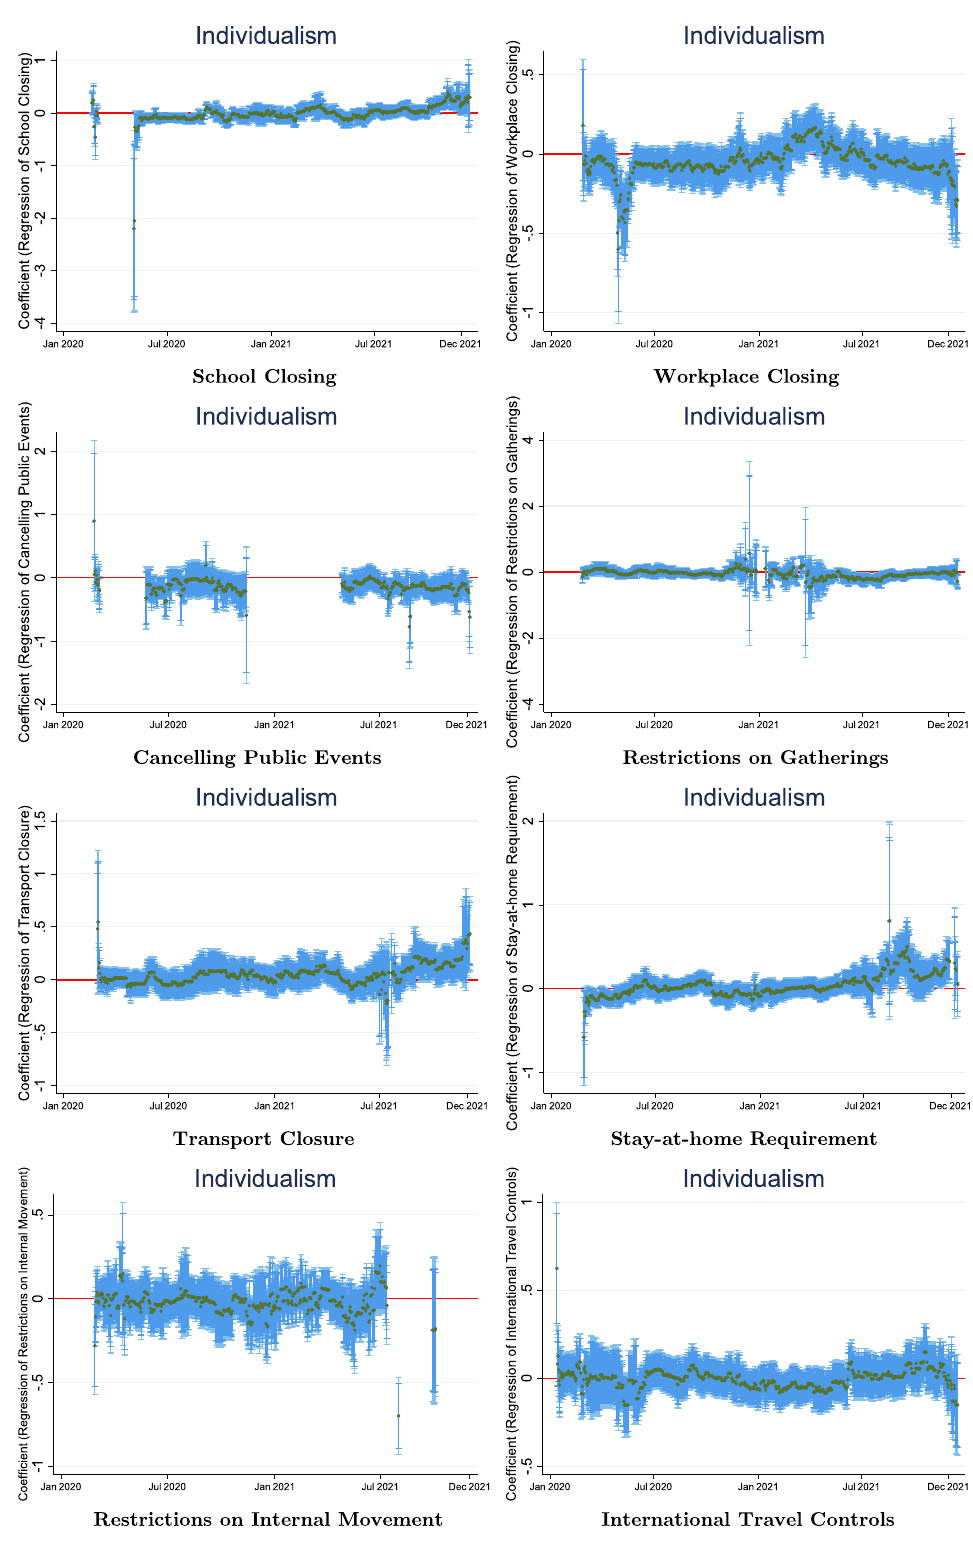
Fig. 2 Regression coef fi cients of virus- fi ghting policies on Individualism. Daily virus- fi ghting policies ordered logit regression coef fi cients (95 and 90% con fi dence interval) on Individualism , controlling for con fi rmed cases, vaccination, virus testing, country characteristics and continent fi xed effects, 2020 and